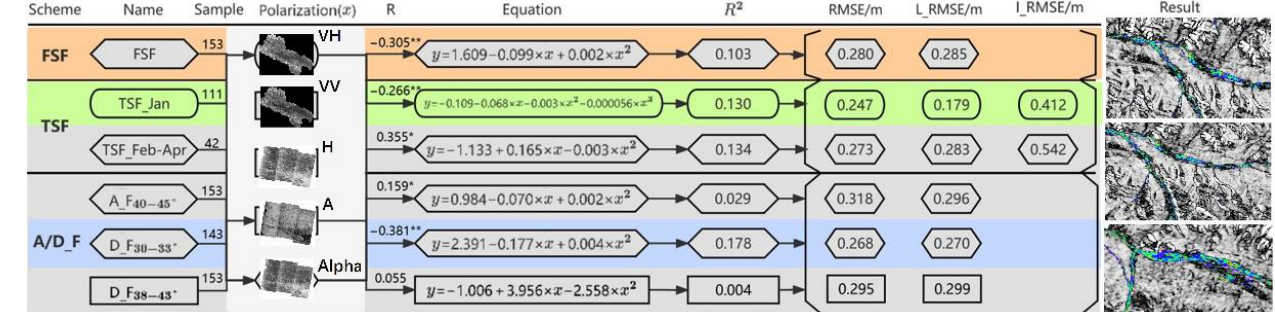
Figure 10. Linear or nonlinear fitted equations for the Binggou River. Two-tailed, 95% confidence interval. * represents significant correlation at the 0.05 level. ** represents significant correlation at the 0.01 level. Entropy is denoted as H , and anisotropy is denoted as A . Rectangular boxes indicate simulations using A , rounded boxes indicate simulations using VH polarization, and pointed boxes indicate scattering angle simulations. The orange, yellow, and blue colors indicate the methods with better accuracy for each scheme. FSF and TSF schemes use images with better correlation for the polarization method, and A/D_F divides the ascending orbit, descending orbit and incidence angle images.